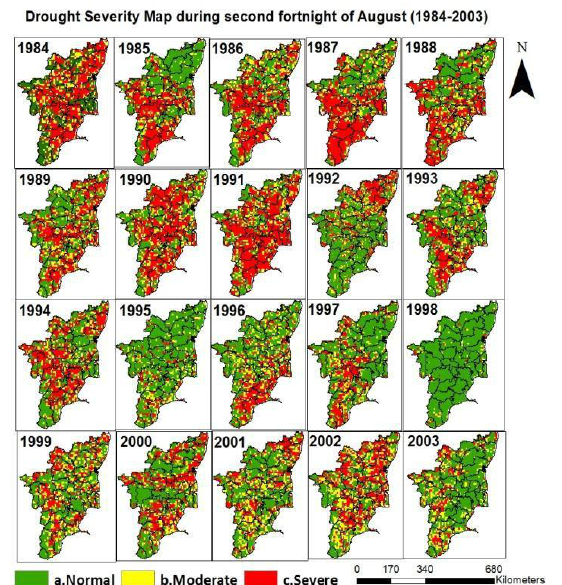
Figure 7 Drought intensity maps for 20 years during August 2nd fortnight